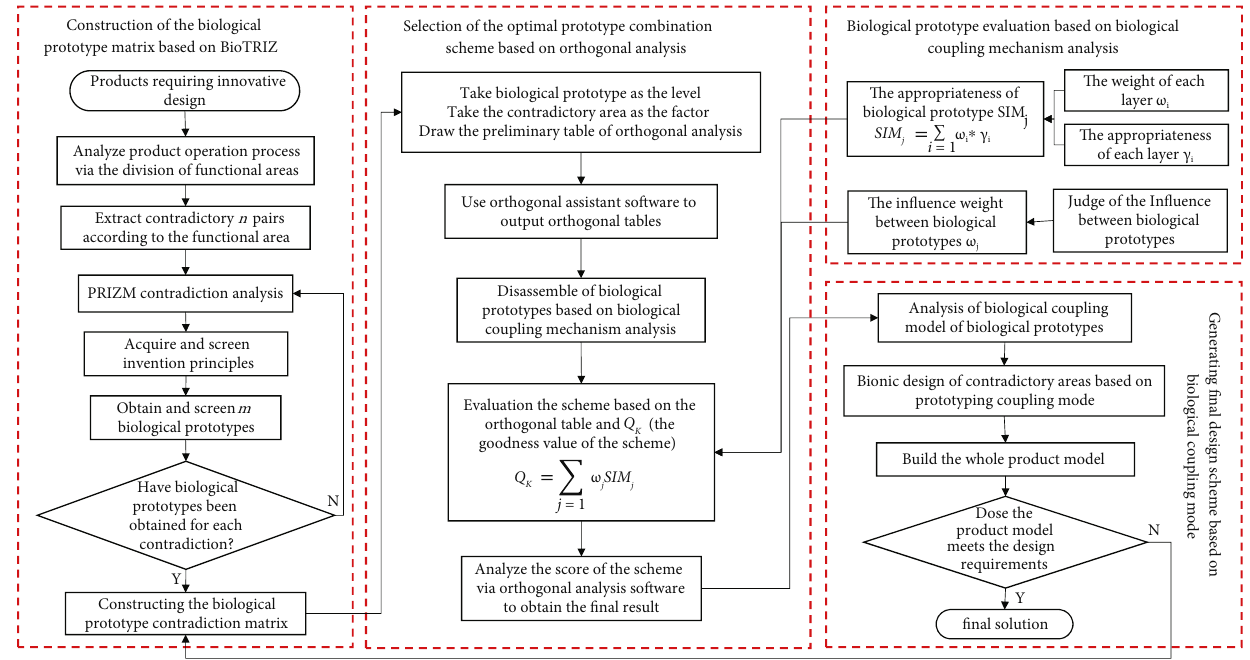
Figure 5: The biomimetic product design process is based on biological